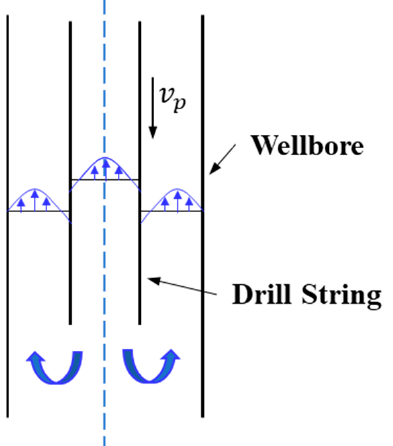
Figure 2. Drilling fluid flow state during the running of the open pipe.